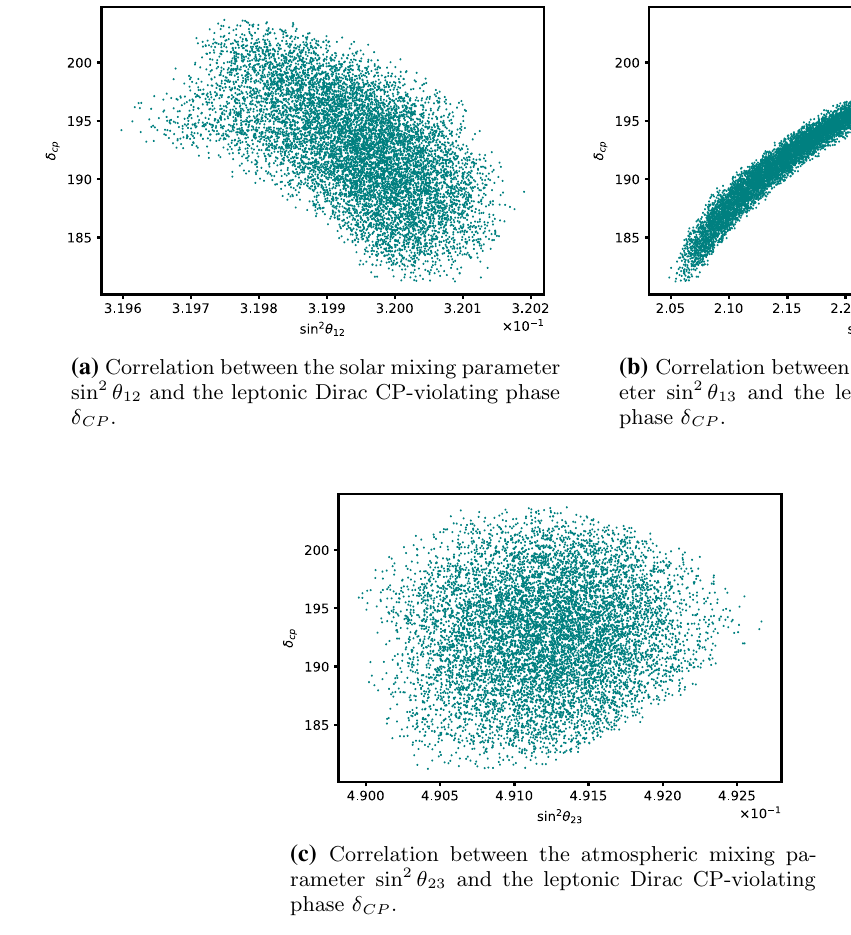
Fig. 1 Correlations between the leptonic mixing parameters and the leptonic Dirac CP violating phase